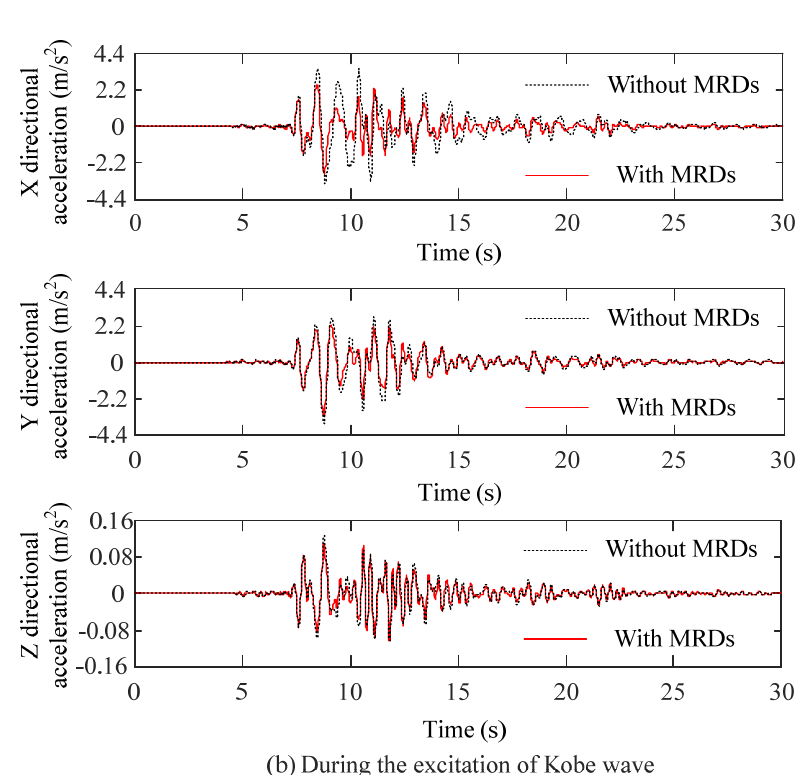
Figure 10. Contrasts of acceleration response of Node 154 of the structure with and without MRDs. According to the differential equation of motion of the MRD damping structure [32], a control force matrix will be added because of the setting of MRDs in the structure; it